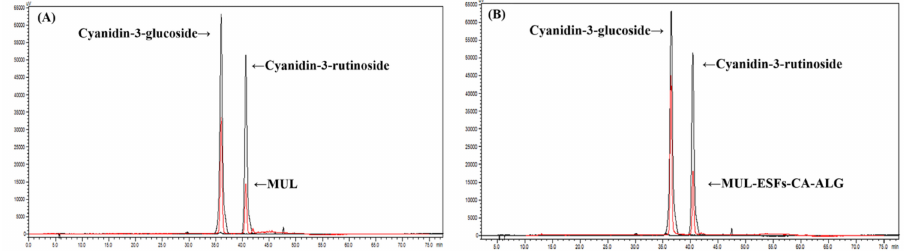
Figure 1. An HPLC chromatogram of cyanidin-3-glucoside and cyanidin-3-rutinoside in MUL. ( A ) MUL, ( B ) solid formulations of the extrudate of MUL treated with 0.5 M citric acid and 0.3% sodium alginate